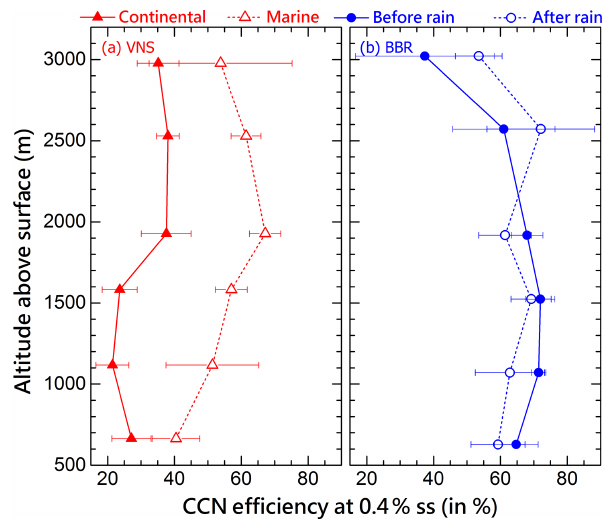
Figure 10. Altitude variation of CCN efficiency at 0.4% supersatu- ration showing the effect of (a) distinct air mass (continental – solid line; marine – broken line) at the central IGP (VNS) and (b) rainfall (before – solid line; after – broken line) at the eastern IGP